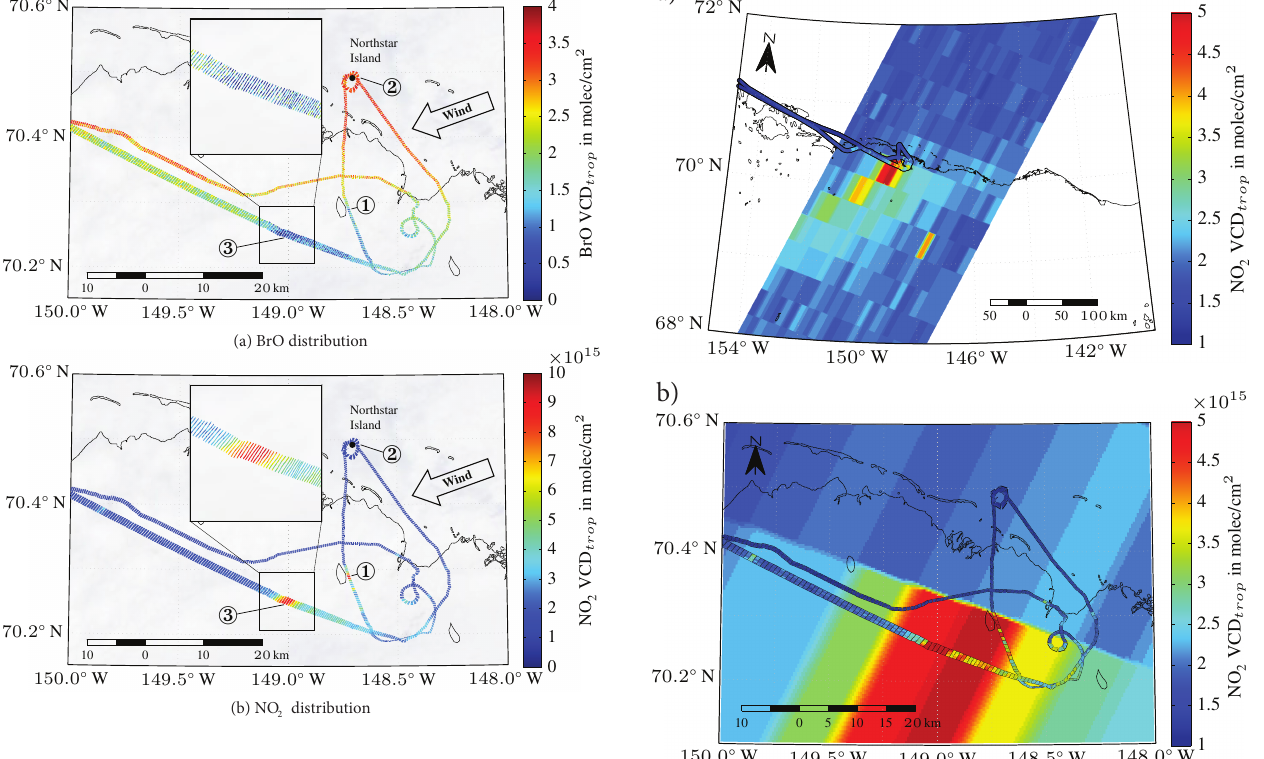
Figure 22. Maps showing a part of the data from the flight to Prud- hoe Bay on 31 March 2012 (01:31–02:30UTC, gray shaded section in Fig. 21), measured by HAIDI’s nadir scanner. Noticeable in the observed trace gas distribution is an anti-correlation between BrO and NO 2 column densities ( ‹ , › , fi ). The background shows a true color satellite image taken from MODIS (Aqua) on the same day with a resolution of 250m (NASA, 2012).